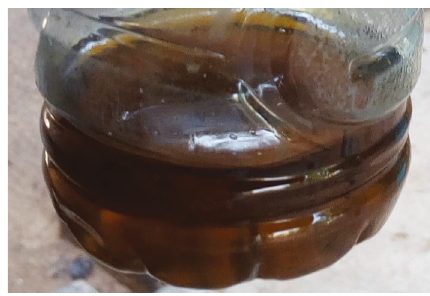
Figure 2: Coca-Cola colored urine.